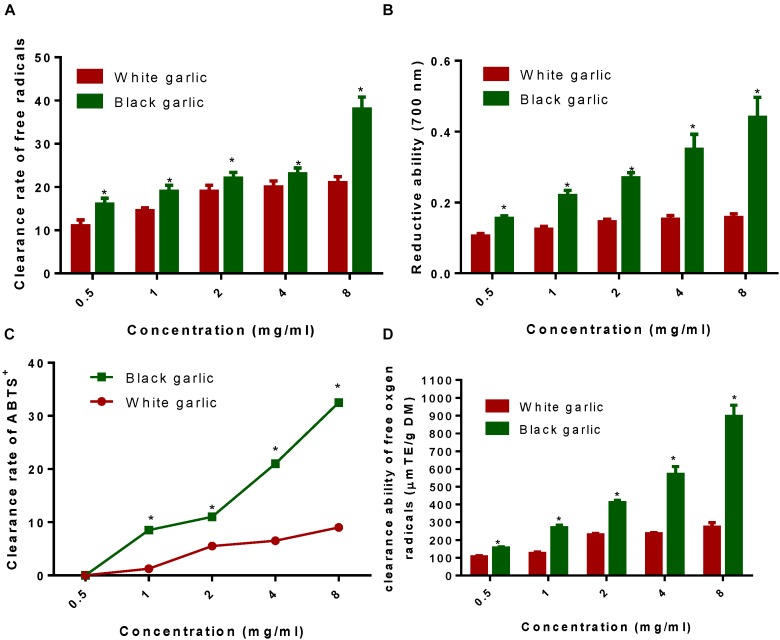
The antioxidant properties of BG. (A) Clearance rate of DPPH-free radicals of BG. (B) Reduction ability of BG. (C) Clearance rate of ABTS radicals of BG. (D) Clearance rate of oxygen-free radicals of BG. ∗Stands for P < 0.05 vs. white garlic.